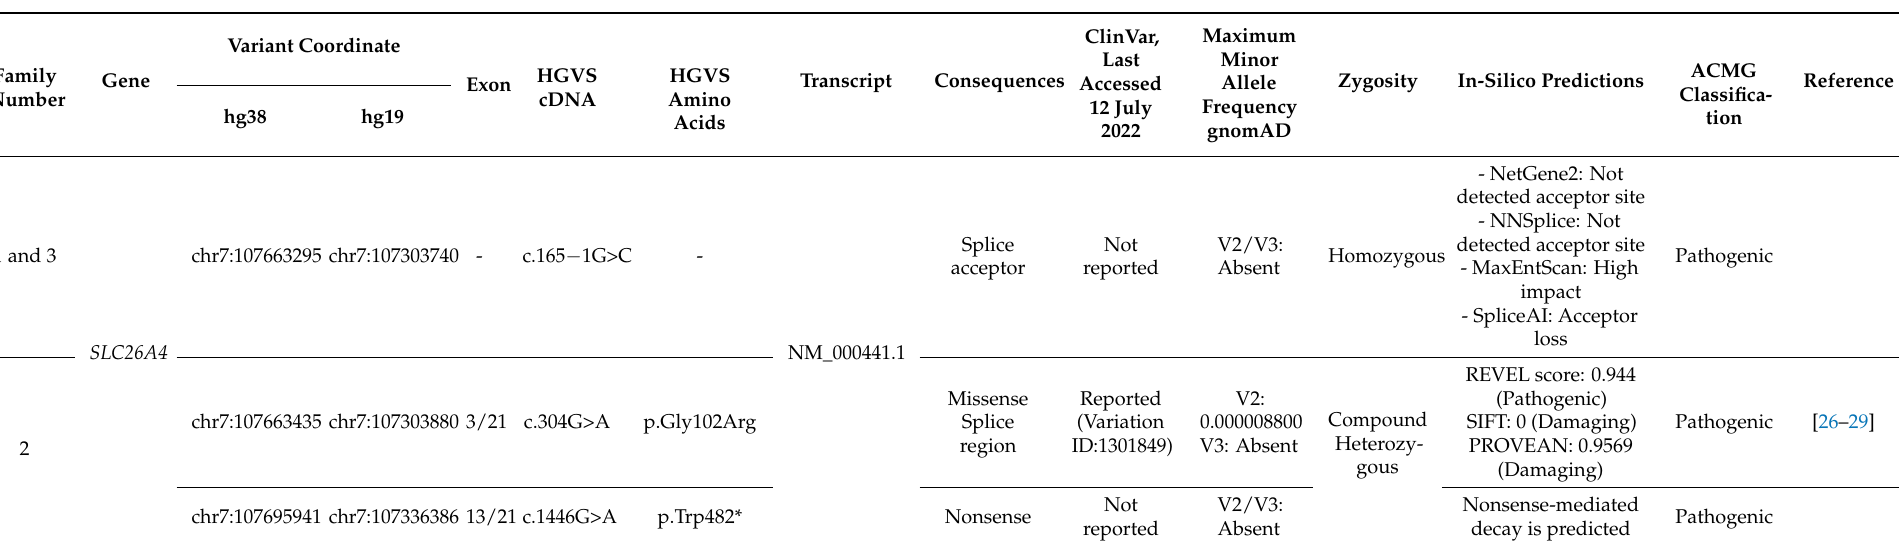
Table 2. Candidate variants identified by whole-exome sequencing in the three